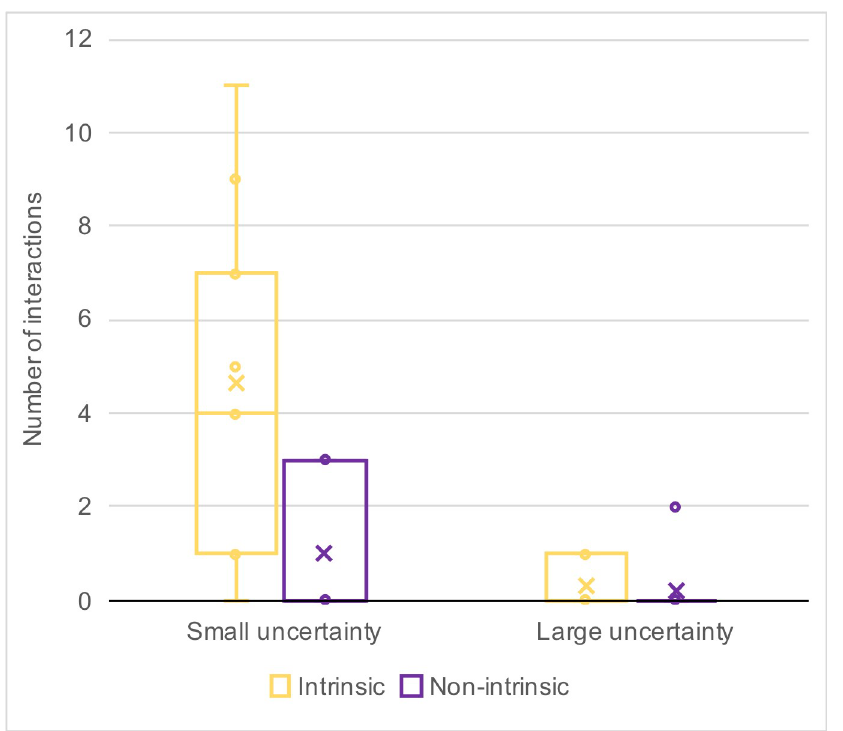
Fig 19. Average number of interactions by uncertainty and motivation type.